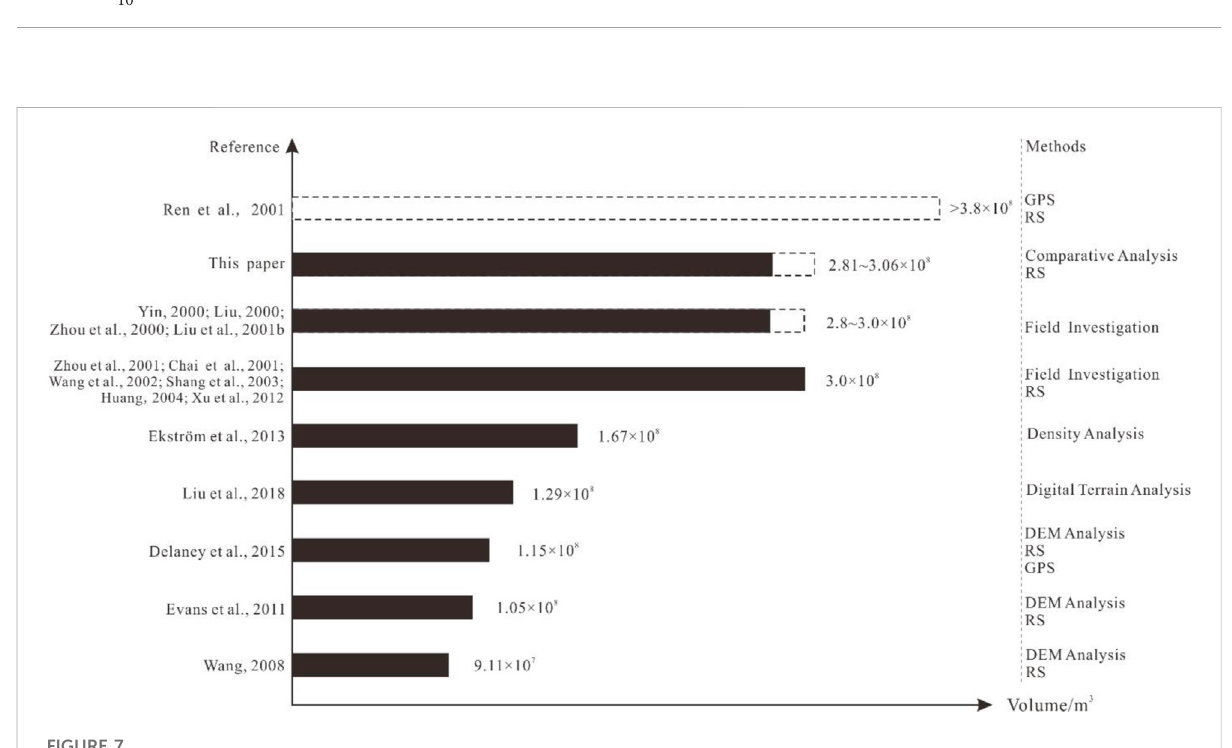
FIGURE 7 Summary of the fi nal deposition volume of the Yigong landslide in